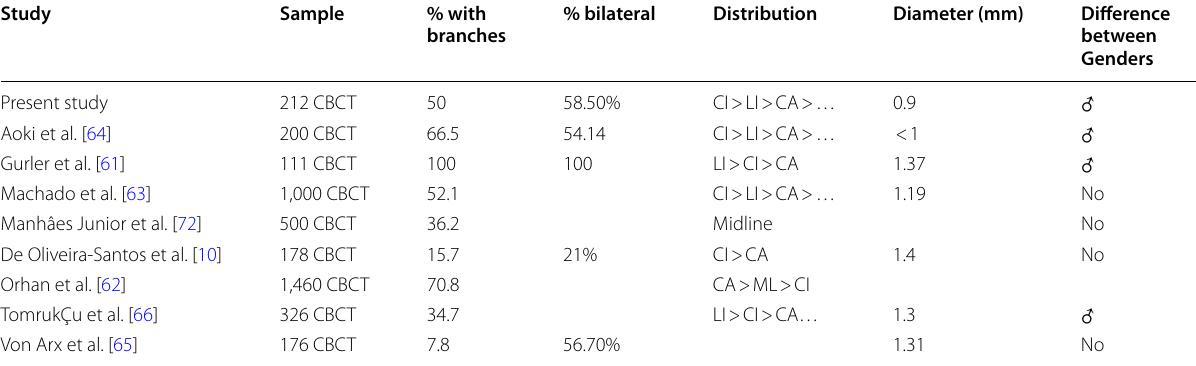
Table 6 Review of data on CS branches from other